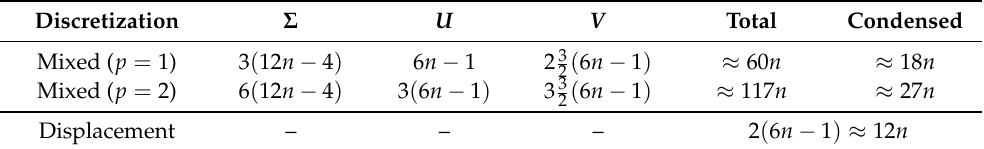
Table 1. Number of degrees of freedom per cell for both mixed discretizations and a pure displace- ment approach. Each vertex dof counts for 1 mesh regime. Total and condensed numbers of dofs are approximated for large values of n .